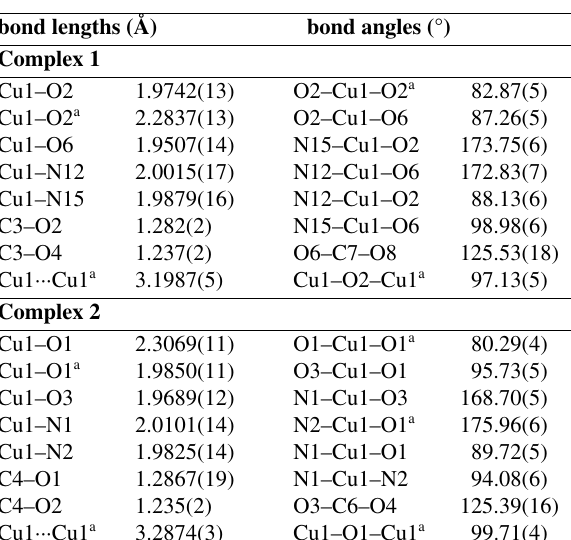
Table 2. Selected bond lengths (Å) and angles (°) in Cu(II) comple- xes